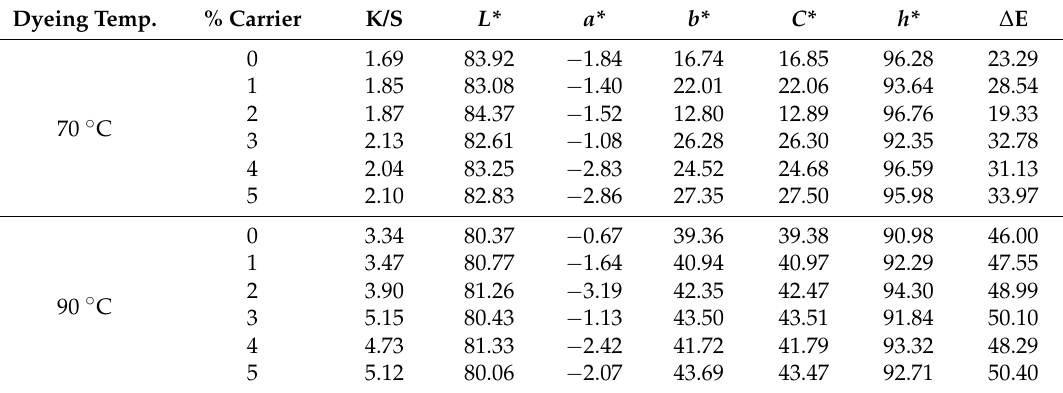
Table 2. Optical measurements of disperse dye 3b on the polyester fabrics. Dyeing Temp. Dyeing